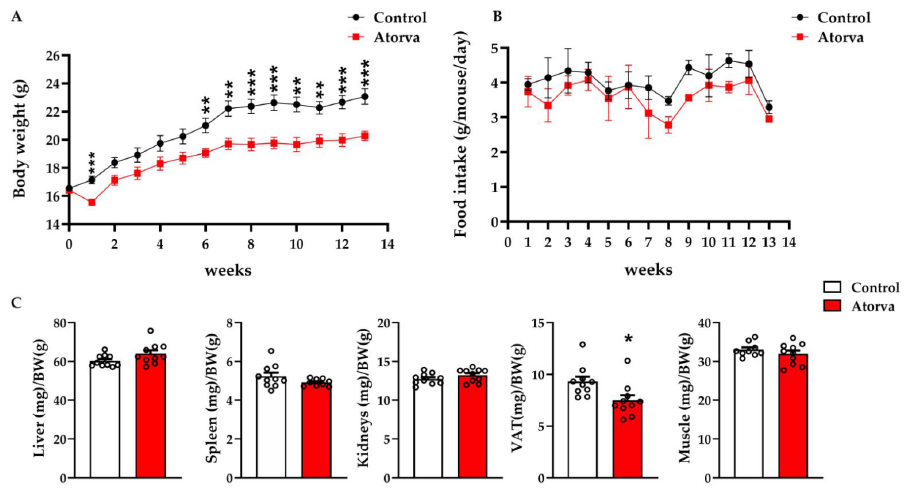
Figure 2. ApoE -/- mice were fed for 12 weeks with HFHC (Control) and HFHC plus atorvastatin. Body weight ( A ) and food intake ( B ) were recorded weekly. Between-group differences were assessed by Student’s t -test. * p < 0.05; ** p < 0.01; *** p < 0.001. Data are depicted as mean ± SEM. Organs were weighed and normalized for body weight ( C ). Atorva, atorvastatin; BW, body weight; HFHC, high-fat high-cholesterol diet; VAT, visceral adipose tissue. n = 10 in each group.